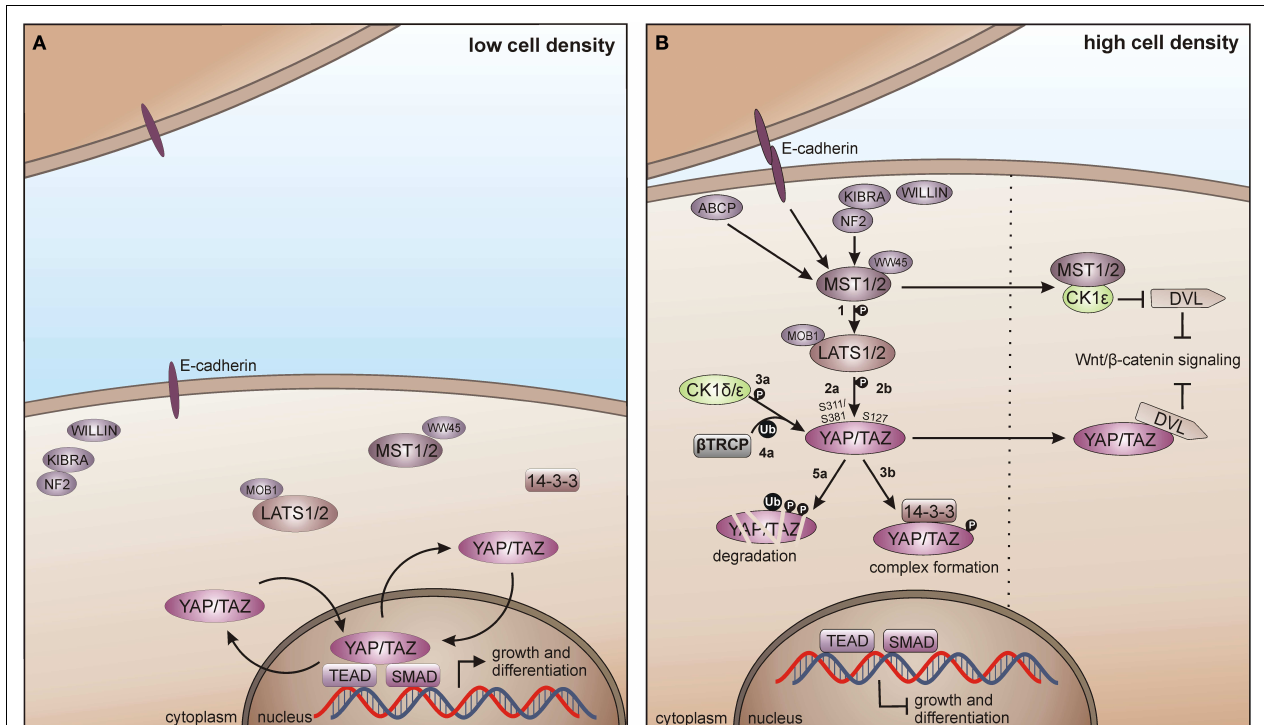
or Ser-381 (2a).This phosphorylation primesYAP/TAZ for further phosphorylation by CK1 δ / ε (3a) and consequent recruitment of and ubiquitination by β -TrCP (4a), primingYAP/TAZ for degradation (5a). However, LATS1/2 driven phosphorylation ofTAP/TAZ on Ser-127 (2b) leads to the formation of 14-3-3-YAP/TAZ complexes, which accumulate in the cytoplasm preventingYAP/TAZ access to the nucleus (3b). Hippo pathway regulates Wnt/ β -catenin signaling by inhibition of DVL, either by MST1/2-mediated prevention of CK1 ε -dependent phosphorylation of DVL, or by direct inhibition of DVL byYAP/TAZ. ABCP: apicobasal cell polarity